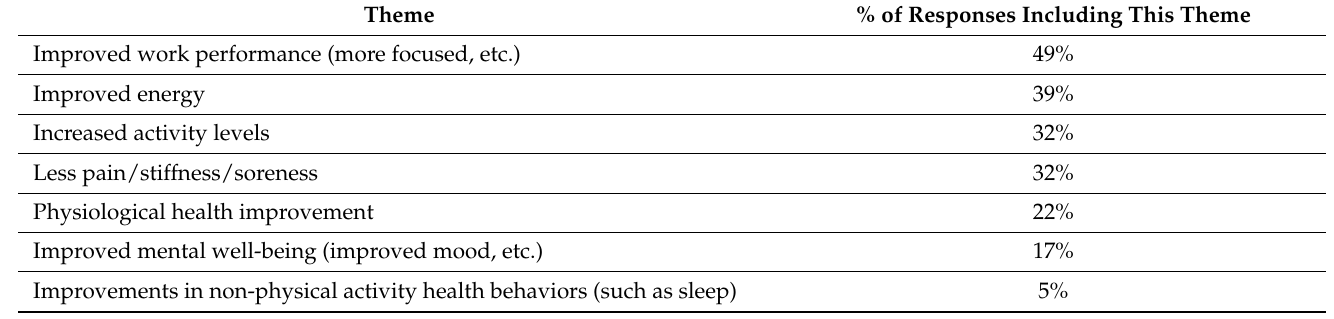
Table 3. Qualitative Analysis of Height-Adjustable Desk Benefits on Employee Mental Well-being and Work Performance.